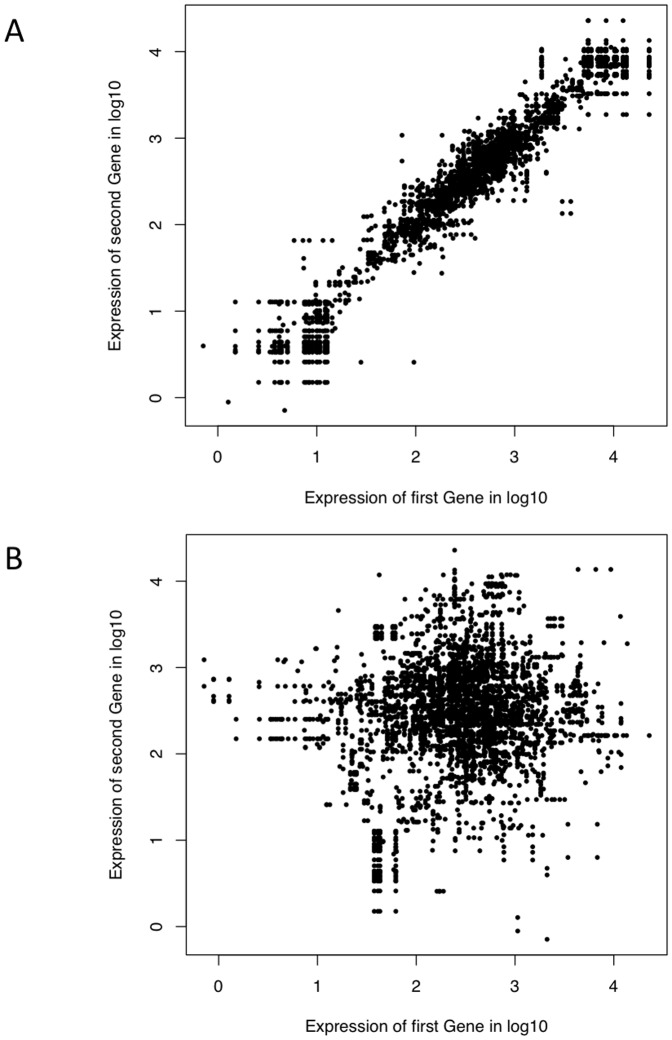
Scatter plot of the expression levels of pairs of adjacent genes.The expression levels of two genes located within the same transcript (A) or separate but adjacent transcripts (B) are plotted in log10 scale.